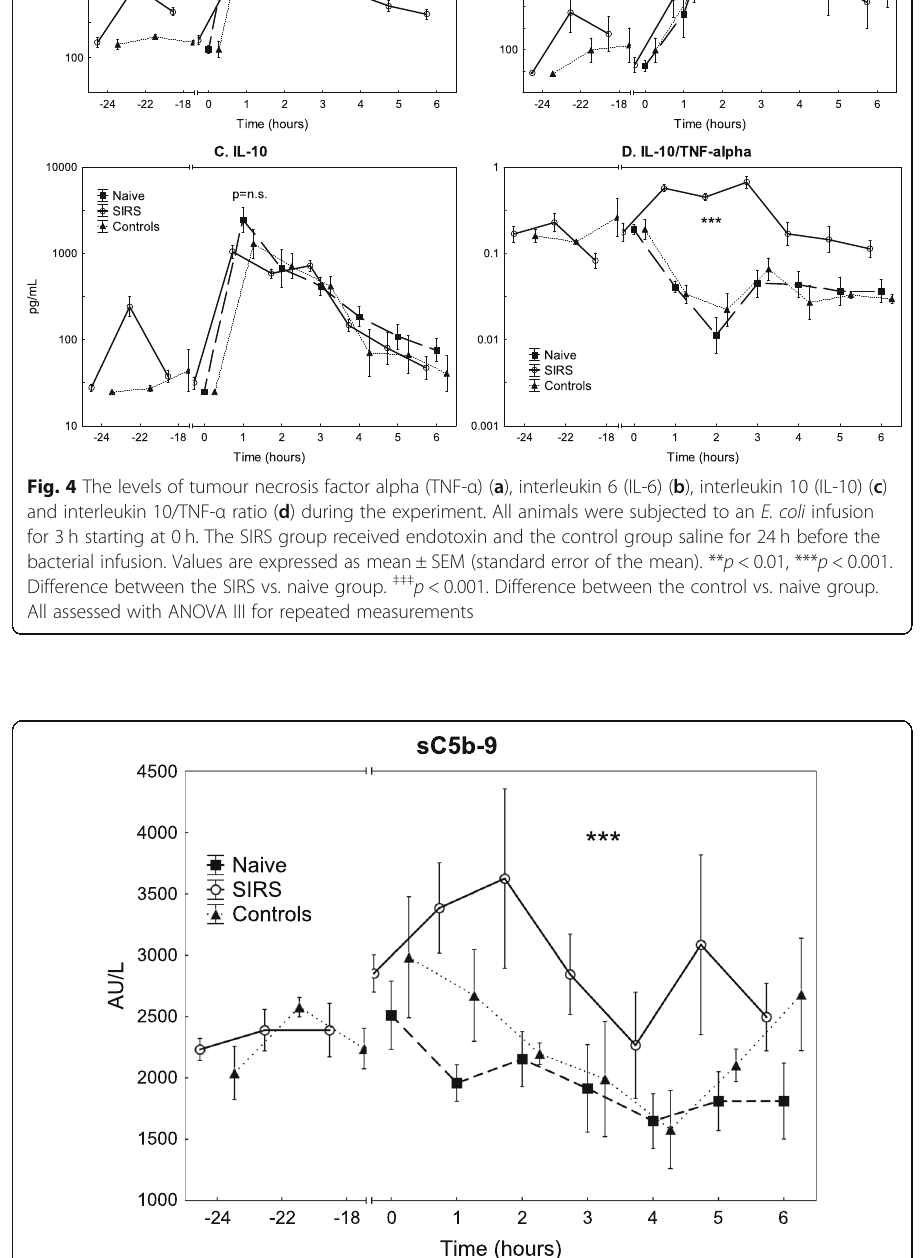
Fig. 5 The levels of complement activation measured as sC5-9 during the experiment. All animals were subjected to an E. coli infusion for 3 h starting at 0 h. The SIRS group received endotoxin and the control group saline for 24 h before the bacterial infusion. Values are expressed as mean ± SEM (standard error of the mean). *** p < 0.001. Difference between the SIRS and naive group as assessed with ANOVA III for repeated